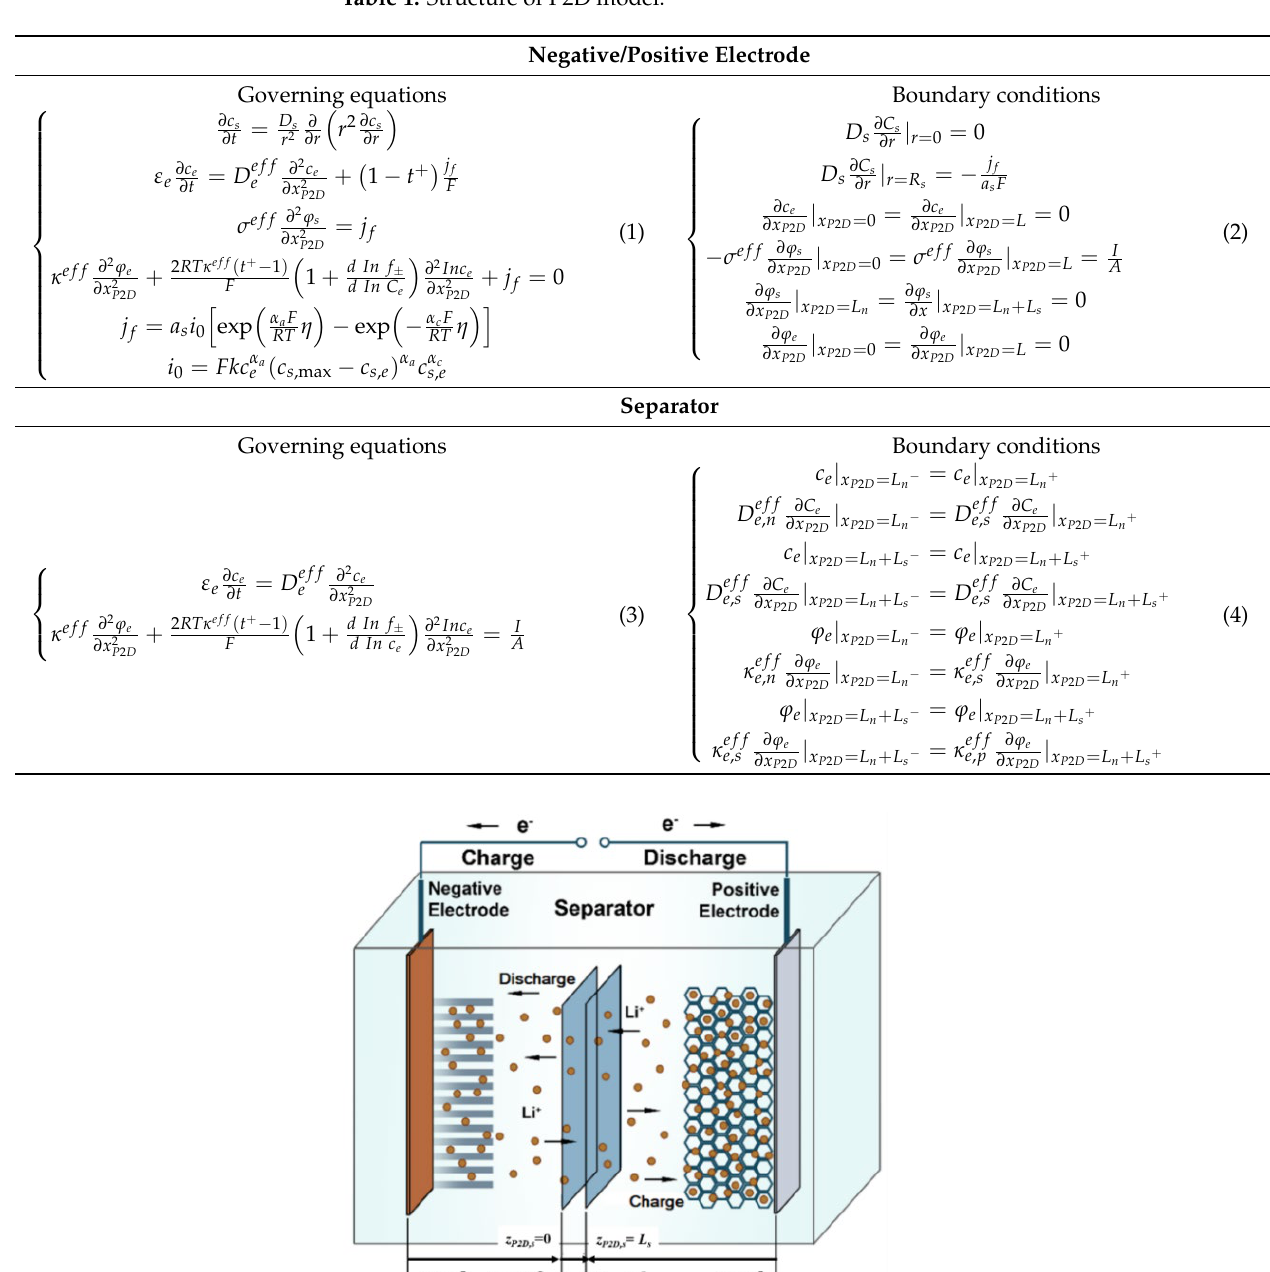
the positive electrode. Figure 2 shows the regions of z P 2 D,n , z P 2 D,s and z P 2 D,p , and Table 2 shows the P2D model in the z P 2 D coordinate. Table 1. Structure of P2D model.